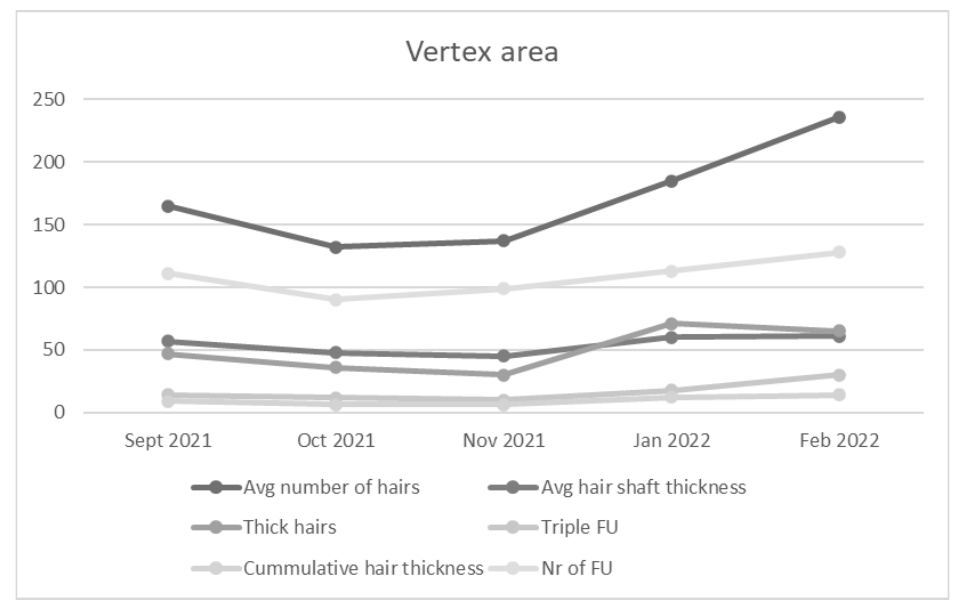
Figure 2. Average number of hairs, Average hair shaft thickness, Thick hairs, Triple FU, Cumulative hair thickness, and Number (Nr) of follicles (F) increased in the vertex area of the first patient.